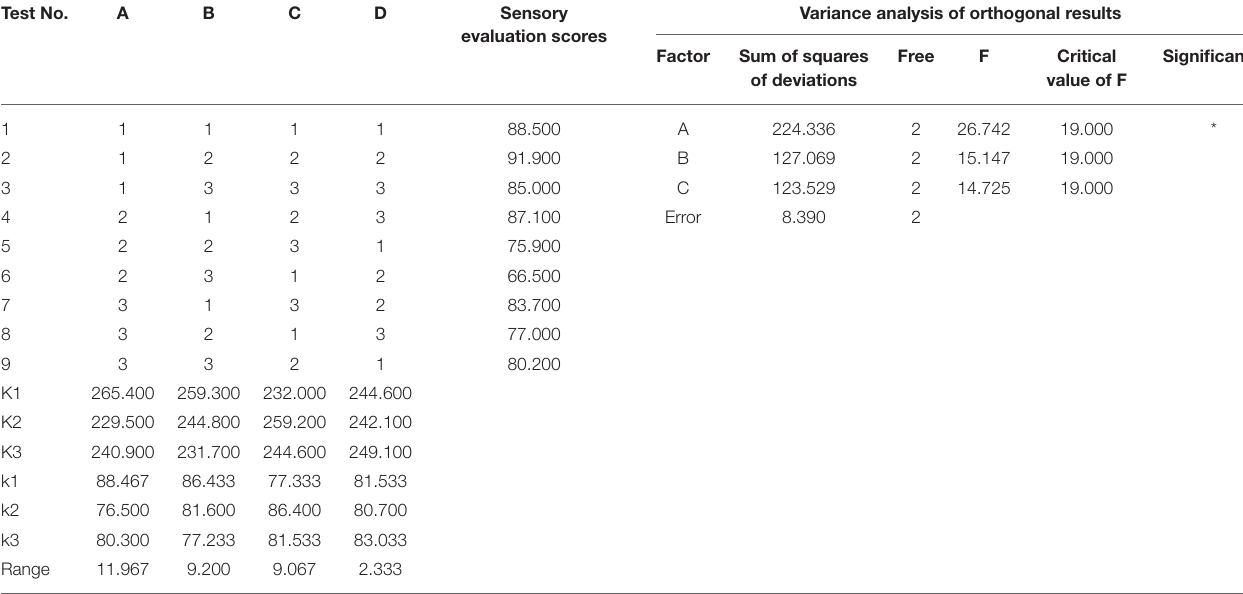
TABLE 3 | Orthogonal experiment results for optimal fermentation conditions of Niuxin plum wines. Test No. C D Sensory